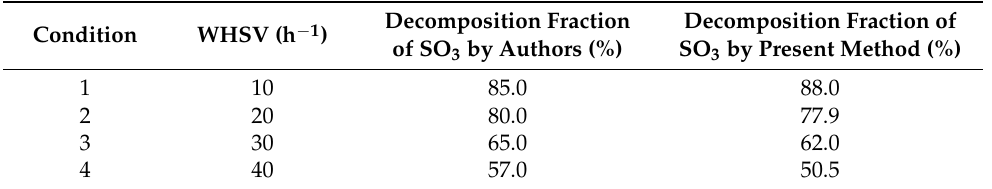
Table 3. Numerical method verification of the decomposition rate.